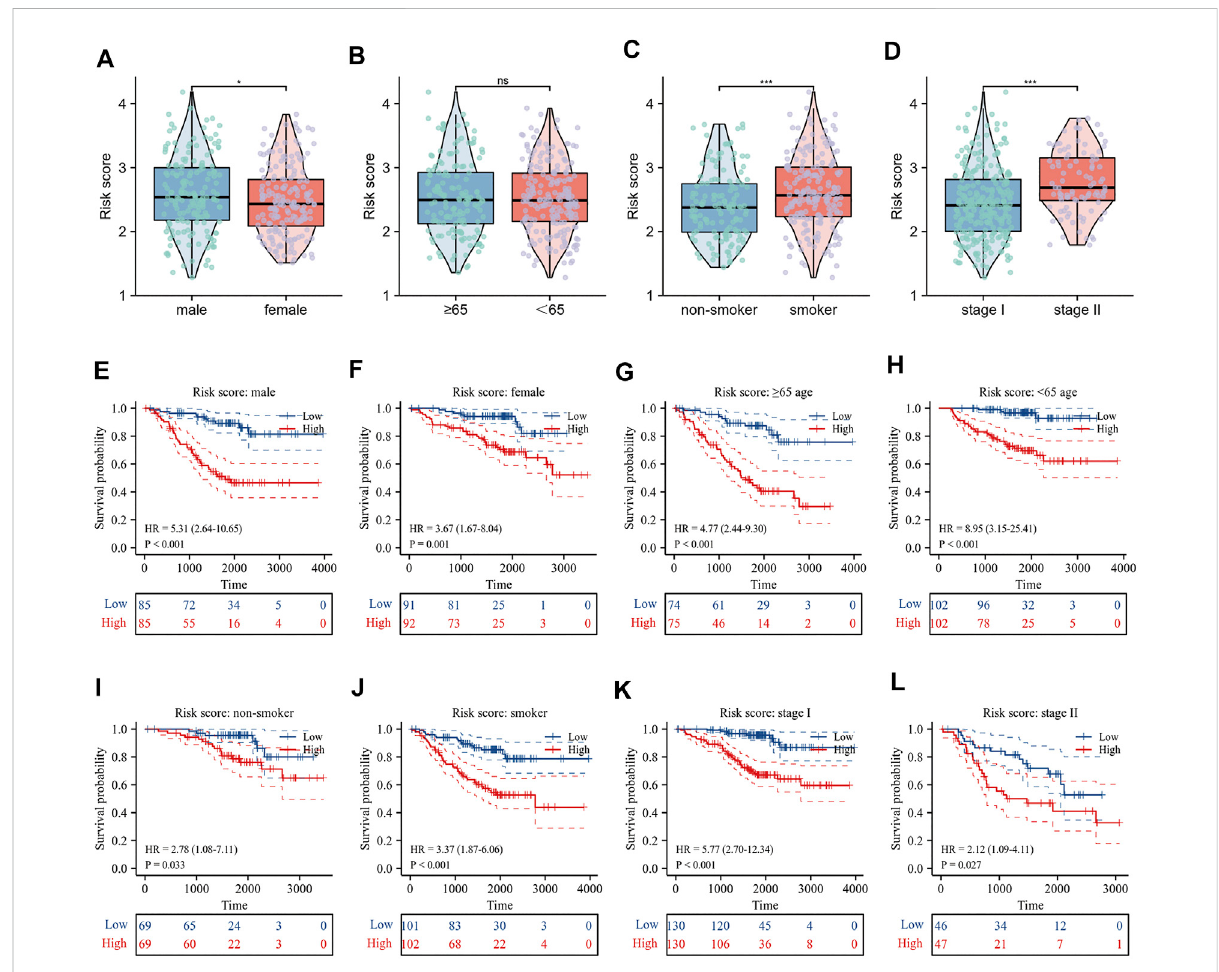
Oocyte meiosis (NES = 1.81) in cluster2 group (Figure